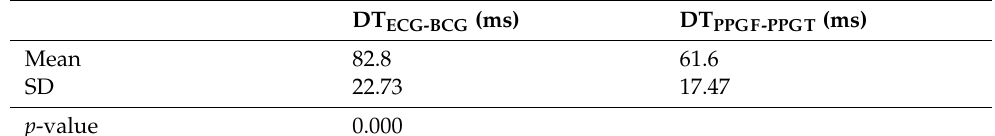
Table 7. The statistic of delay time (DT ECG-BCG ) between the ECG and BCG, and the delay time (DT PPGF-PPGT ) between the PPG F and PPG T . DT ECG-BCG (ms) DT PPGF-PPGT (ms) Mean 82.8 61.6 SD 22.73 17.47 p -value